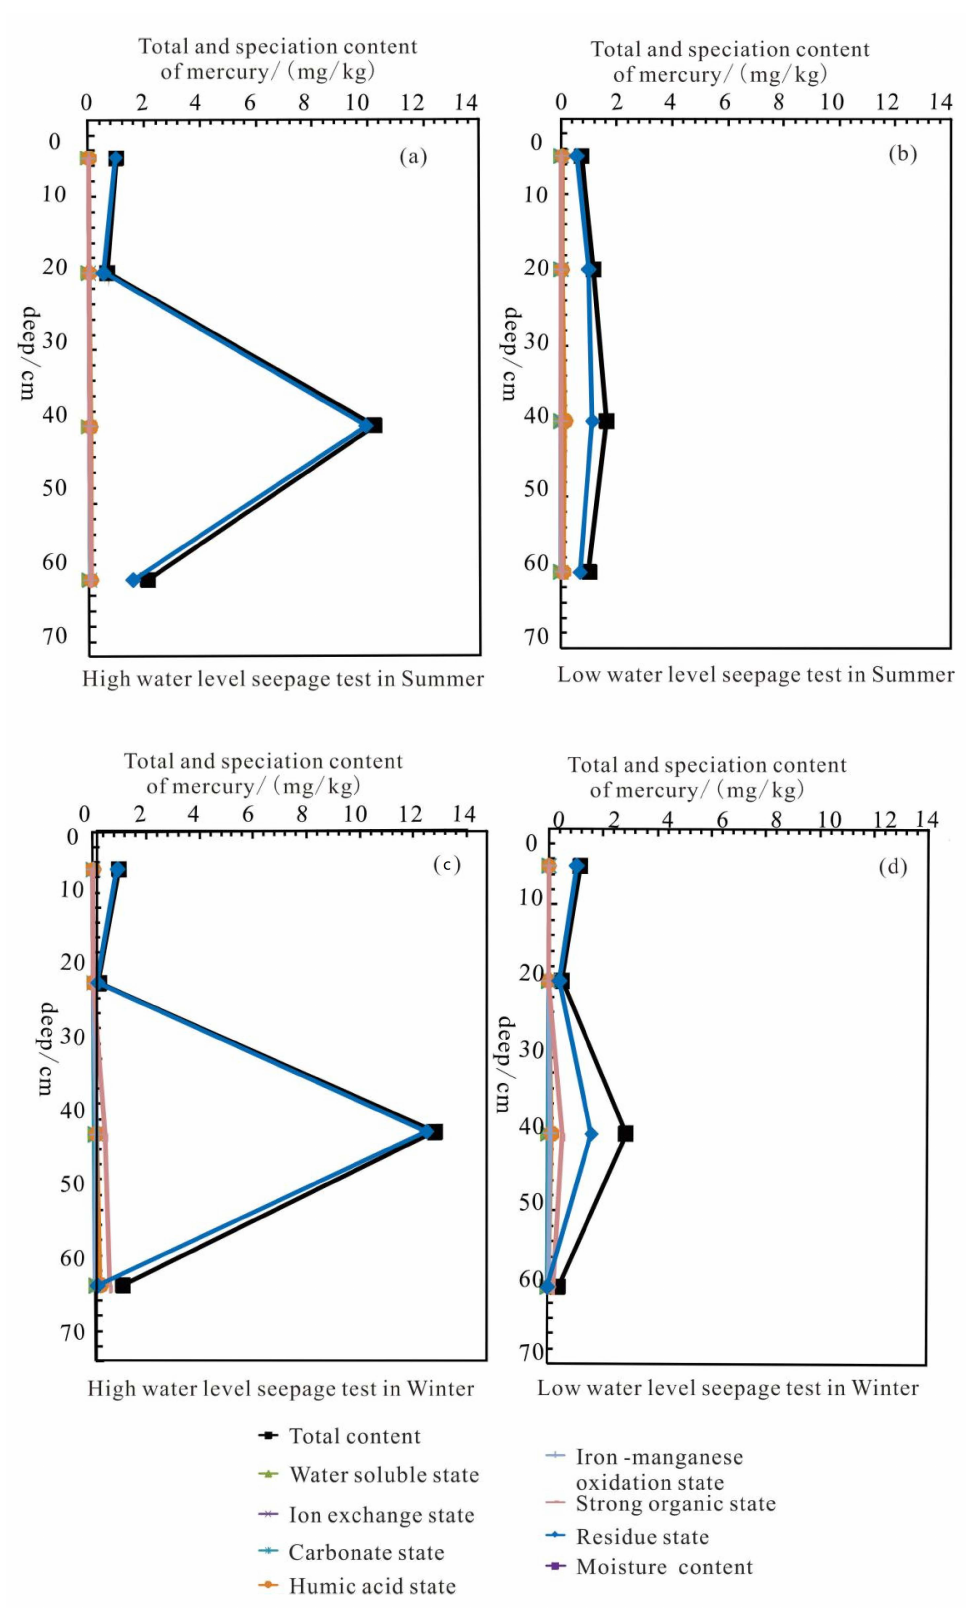
Figure 3. Characteristics of mercury transport in the subsurface under different hydrodynamic excitation conditions in wet and dry